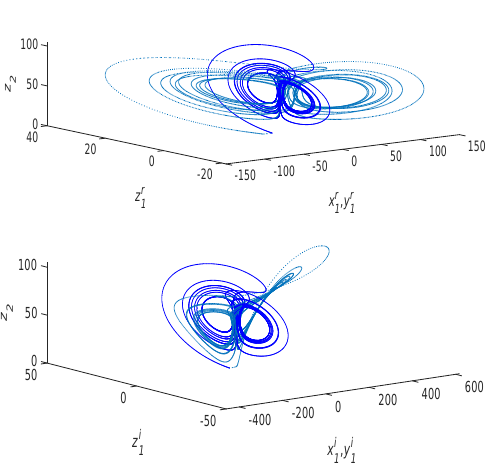
Figure 3. The projection space of chaotic systems L 1 and L 2 without noise.